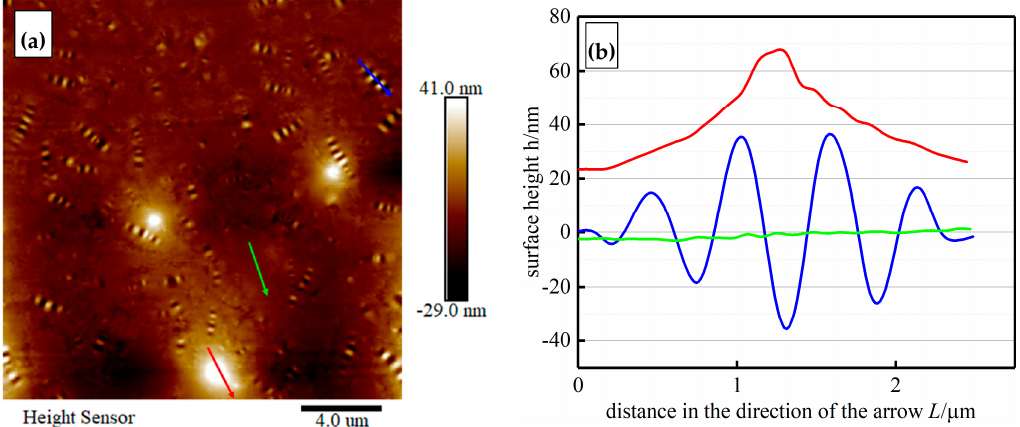
Figure 12. 2D AFM morphology images ( a ) and surface height curves along arrow directions of the mastics ( b ).